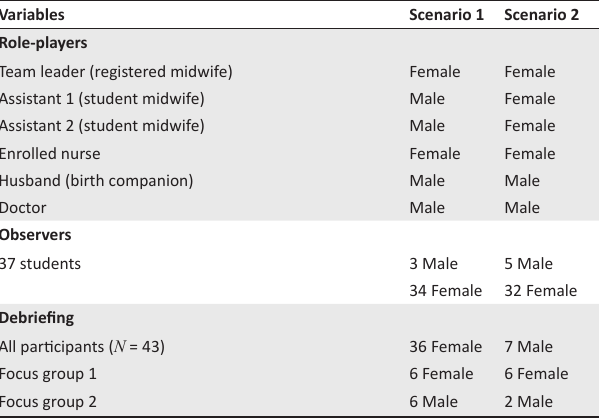
TABLE 1: Gender demographics of